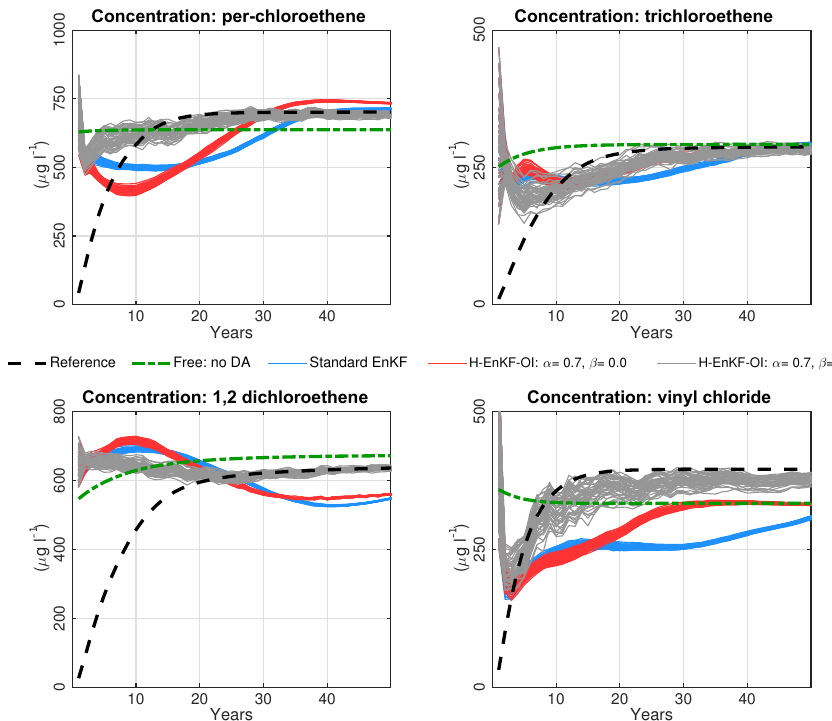
Figure 9. Forecast ensemble members of the PCE, TCE, DCE and VC concentrations. The evolution of these members ( N e = 48) is shown for the entire 50 years. Results are obtained using the standard EnKF, the EnKF-OI α = 0 . 7 and the EnKF-OI β dashed and dashed-dotted (green) lines correspond to the reference and free run concentration of each